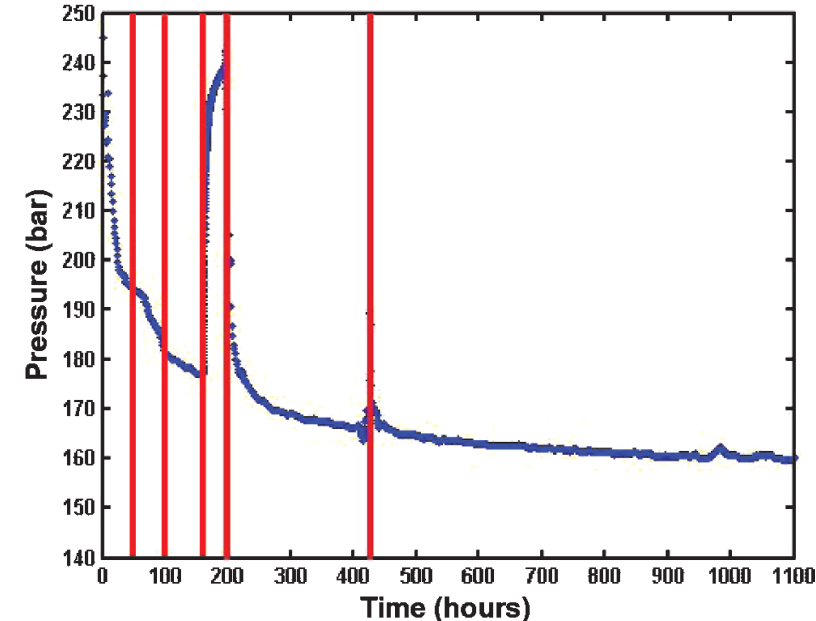
Figure 6. Detection result using the pressure slope from Viberti